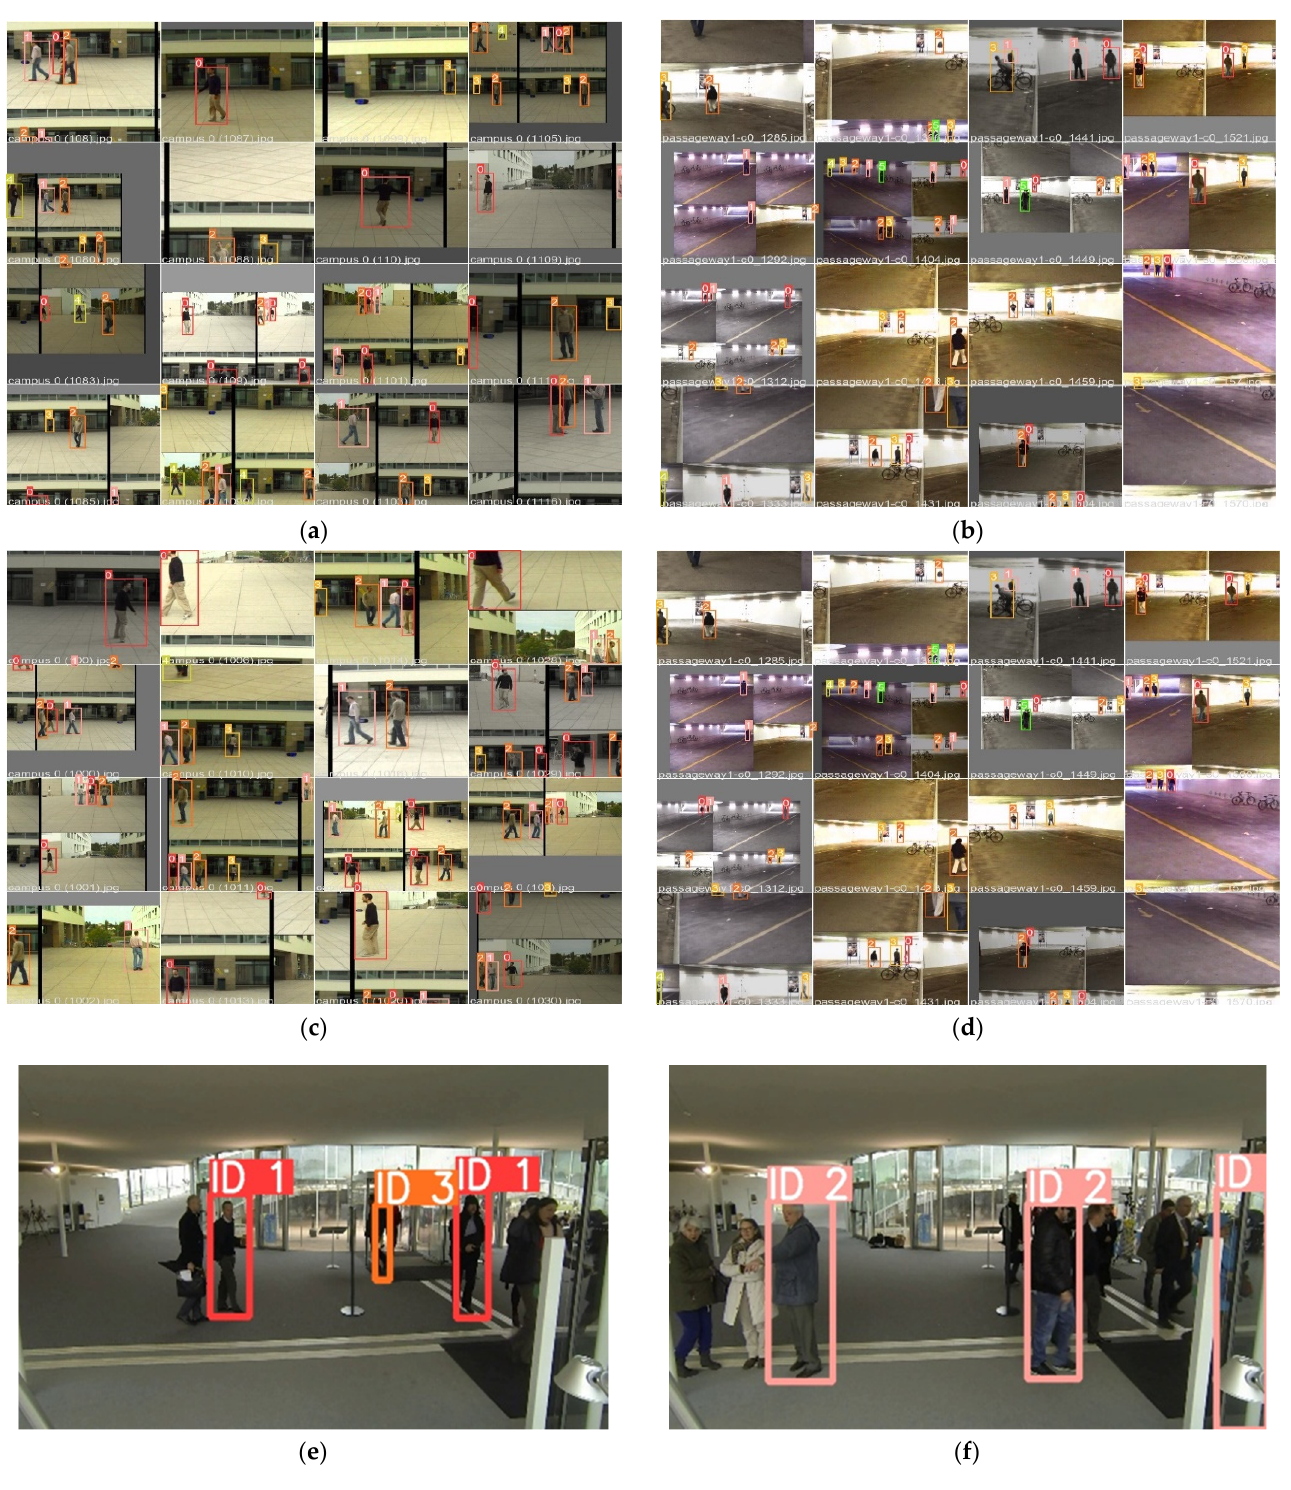
Figure 9. The first row shows visualize ( a , b ), the tracking results on validations of both sequences (Campus and Passageway, respectively) with proposed the HCNN algorithm’s tracker. While ( c , d ) shows the tracking results of the fine-tuned Yolov5 + Deepsort, (Yolo5Deep) model integrated with HOG and Kalman Filter. ( e , f ) shows the EPFL-RCL Multi-cameras frame results for the proposed HCNN without a Kalman Filter and segmentation technique. Compared to our detector and tracker with Yolo5Deep, our proposed algorithm increased positive detections and improved the precision of detection boxes. Moreover, the method is robust for occlusion, illumination, and re-appearance variations. Table 1. Comparison with state-of-the-art methods based on MOT Classification Accuracy.